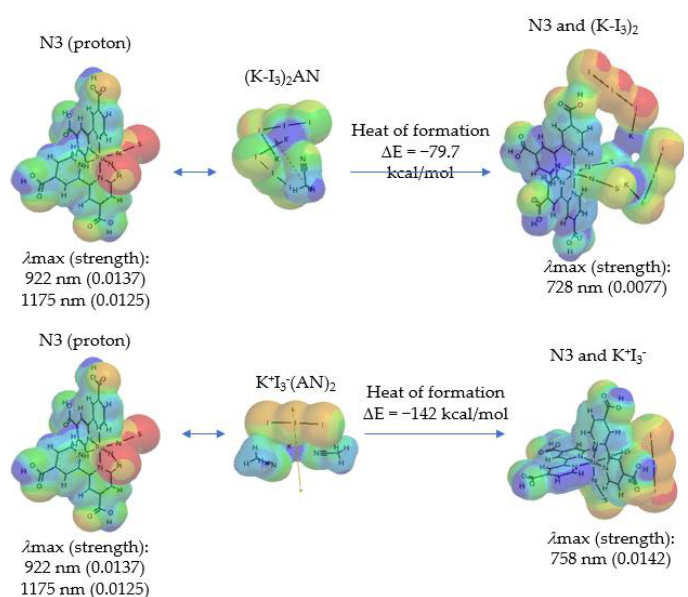
Figure 9. Van der Waals Aggregation of N3 with potassium triiodide to respective N3 and (KI 3 ) 2 and N3 and K + I 3 − .